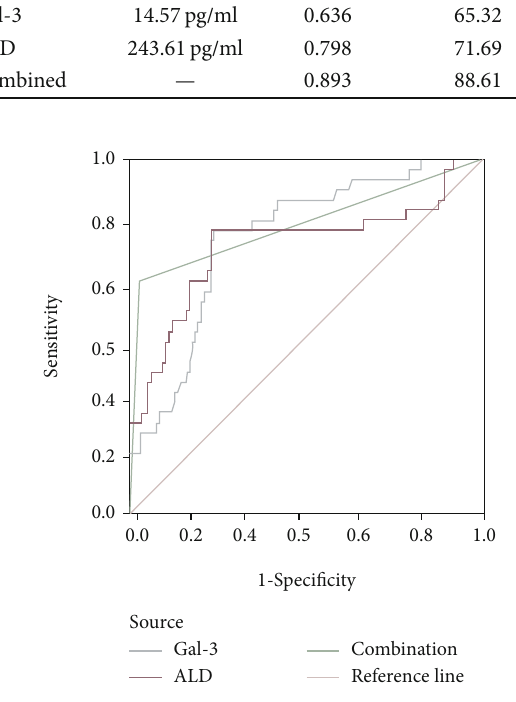
Figure 1: Analysis of preoperative Gal-3, ALD, and 2 combined for predicting AF recurrence after RFCA with ROC